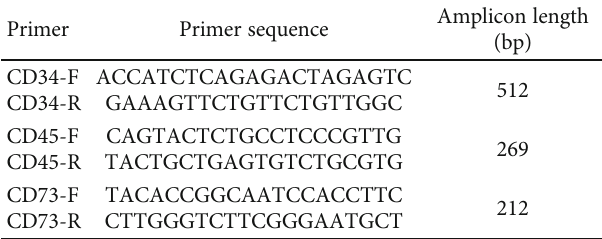
Table 1: Sequences of RT-PCR primers used to quantify the expression of bone marrow-derived mesenchymal stromal cell- speci fi c surface markers (CD73) and hematopoietic stem cell- speci fi c surface markers (CD45 and CD34) in